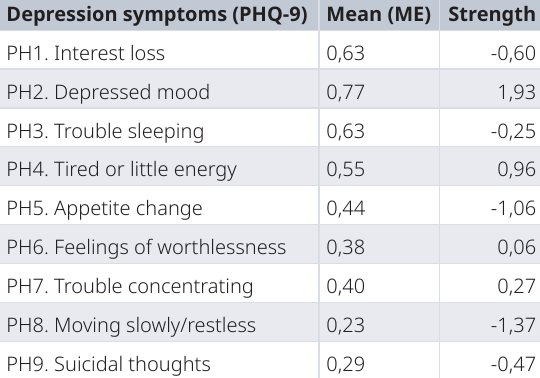
Table 1. Mean and power centrality of items of